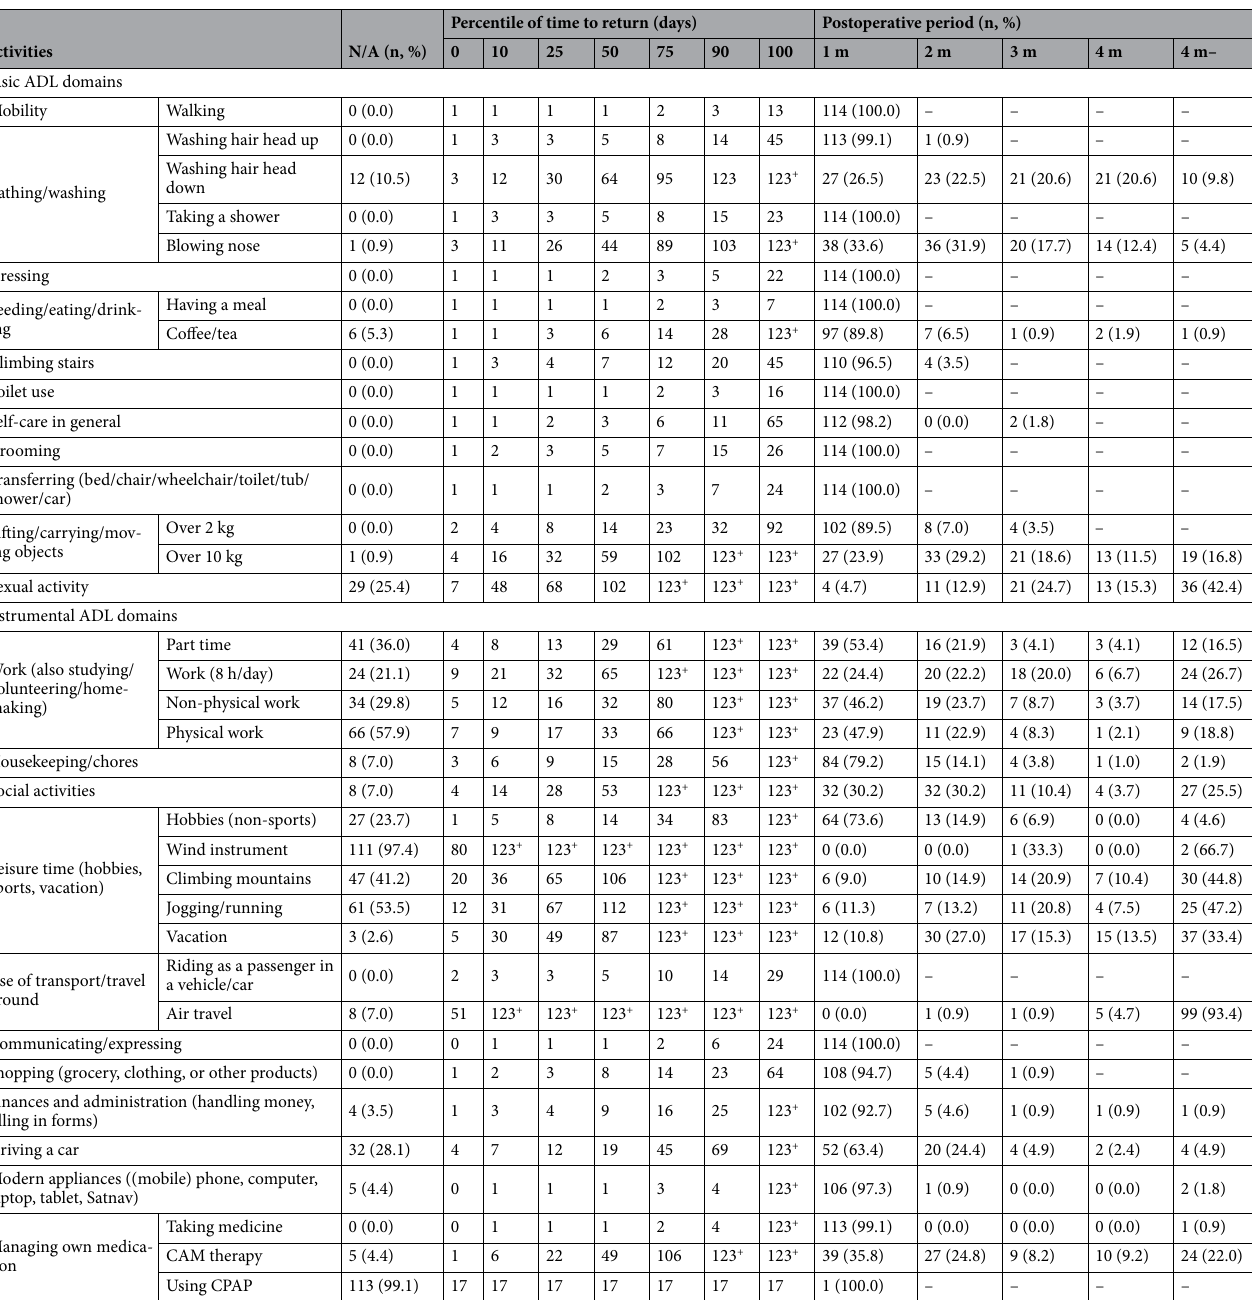
Table 2. Time to return to ADL after surgery (N = 114). 123 + , After 123 days; ADL Activities of daily living, CAM Complementary and alternative medicine, CPAP Continuous positive airway pressure, N/A Not